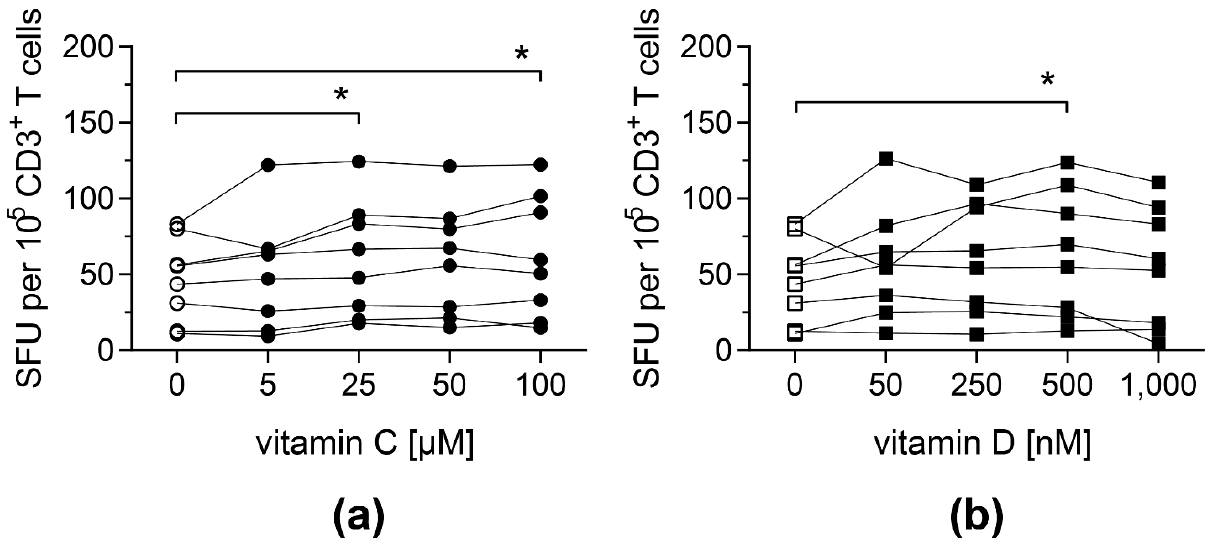
Figure 1. Frequencies of IFN- γ -secreting T cells upon stimulation with pp65pp are enhanced by vitamin C and vitamin D supplementation. IFN- γ secretion of T cells was measured by IFN- γ ELISpot assay, in which PBMCs were stimulated with an overlapping peptide pool of the CMV phosphoprotein pp65 (pp65pp) in the presence of the indicated concentrations of ( a ) vitamin C and ( b ) vitamin D. Shown are spot-forming units (SFU) per 10 5 CD3 + T cells. Symbols connected with one line represent data from one donor ( n = 8). Friedman’s test and post hoc Dunn’s test were used to determine statistical significance (* p < 0.05). Only significances to controls not supplemented with vitamins (0 µM) are shown.